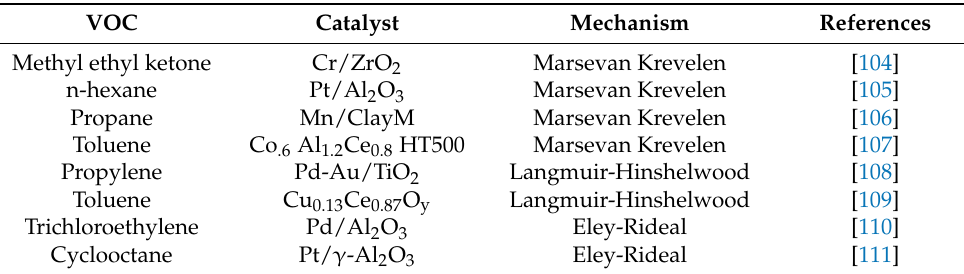
Table 3. Application of different catalytic oxidation